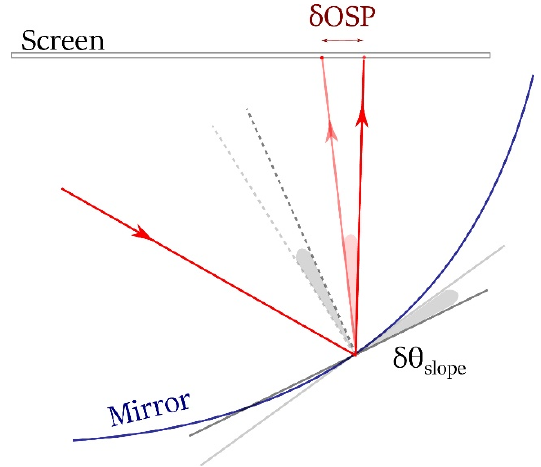
Figure 2. Sketch of the principle of laser profilometry. The red lines represent incoming and reflected laser beams. If the surface is ideal, the laser will follow the path indicated by the light colors. Actually, the real path is indicated by the lines in dark colors.